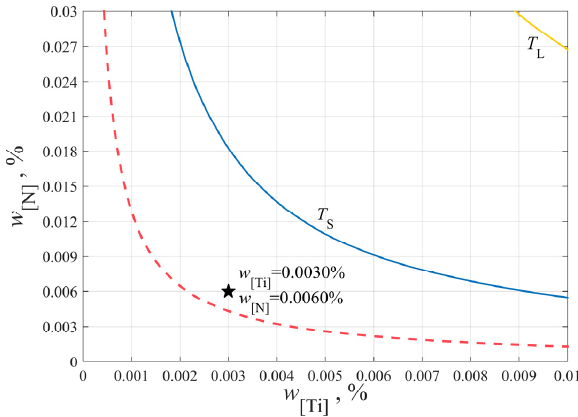
Figure 4. The stability diagram of TiN inclusions precipitation considering solidification segregation.